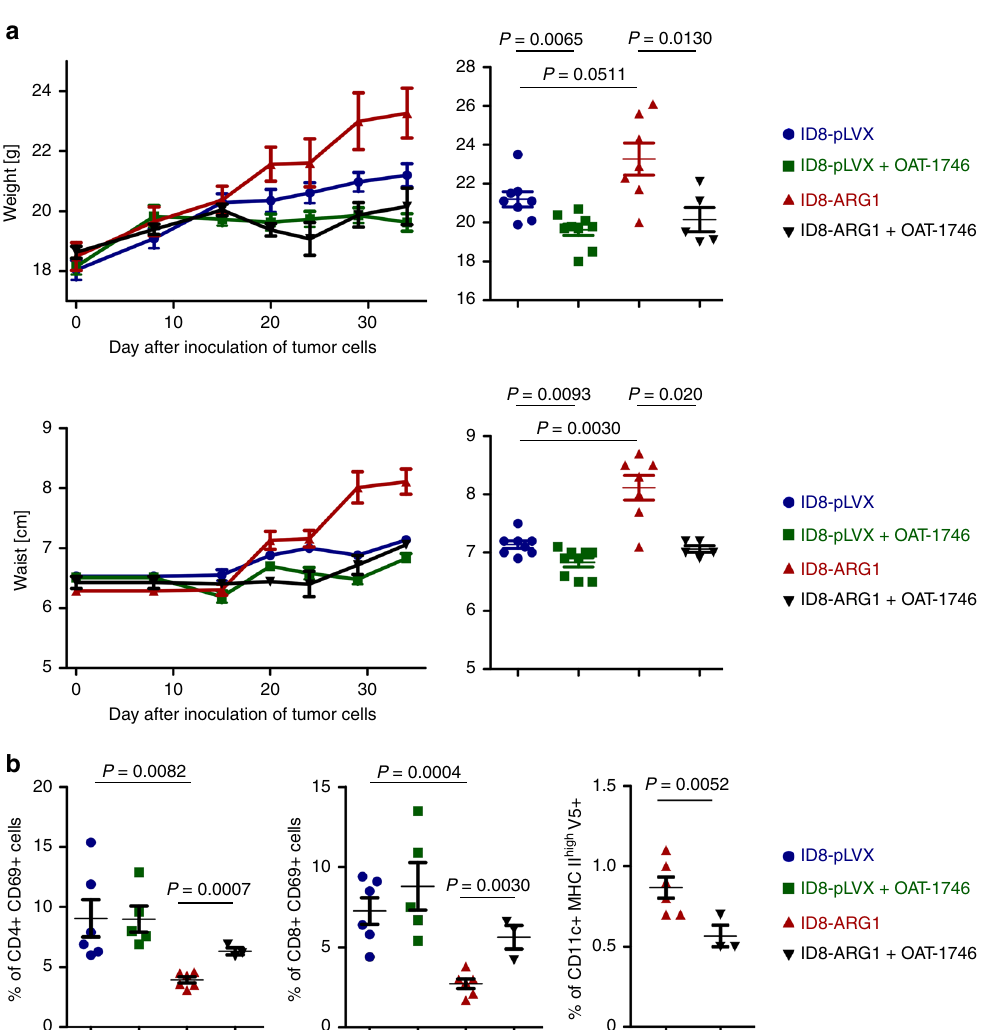
Fig. 7 ARG1 promotes tumor growth in vivo. C57BL/6 mice were inoculated i.p. with 4 × 10 6 ID8- VegfA/Defb29 cells transduced with V5-tagged murine ARG1 (ID8-ARG1-V5) or the control vector (ID8-pLVX). a Mice were treated from day 14th after tumor inoculation with OAT-1746 or PBS i.p. twice daily and monitored for tumor development until fi rst mice met the humane endpoint criteria described in the “ Methods ” section. Increase in mice weight (upper left) and waist circumference (lower left) in time compared to day 0 (day of tumor cells i.p. inoculation) as a measure of ovarian cancer progression/ ascites development. Measurements of gained weight (upper right) and percentage of gained waist circumference (lower right) on day 34 after inoculation of tumor cells. Each experimental group consisted of n = 5 – 9 mice. Data show means± SE. b Mice were treated from day 14th after tumor inoculation with OAT-1746 ARG inhibitor or PBS i.p. twice daily for consecutive 2 weeks. After 2 weeks of treatment cells from ascites were isolated and analyzed by fl ow